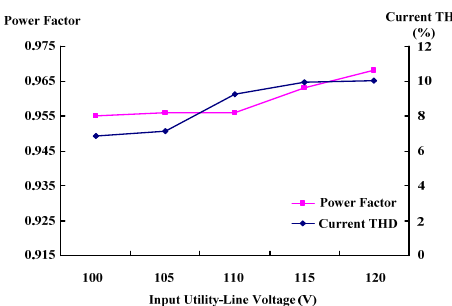
Figure 14. Measured input-current harmonics compared with the IEC 61000-3-2 Class C standards. Appl. Sci. 2017 , 7 , 115